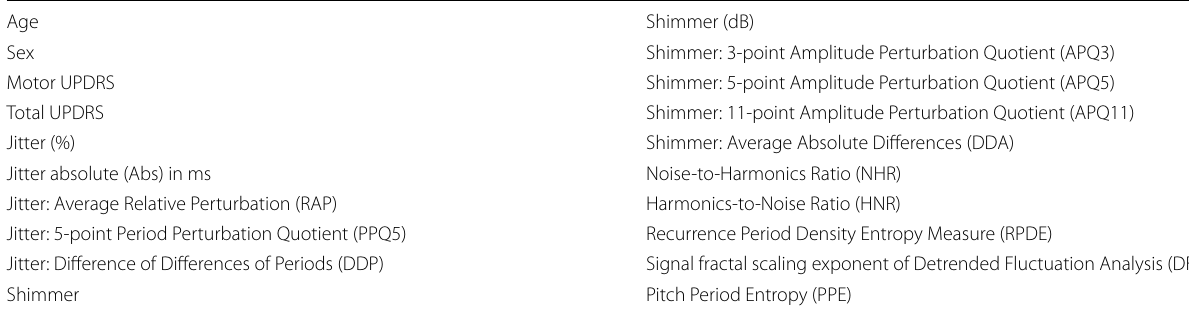
Table 2 Dataset columns